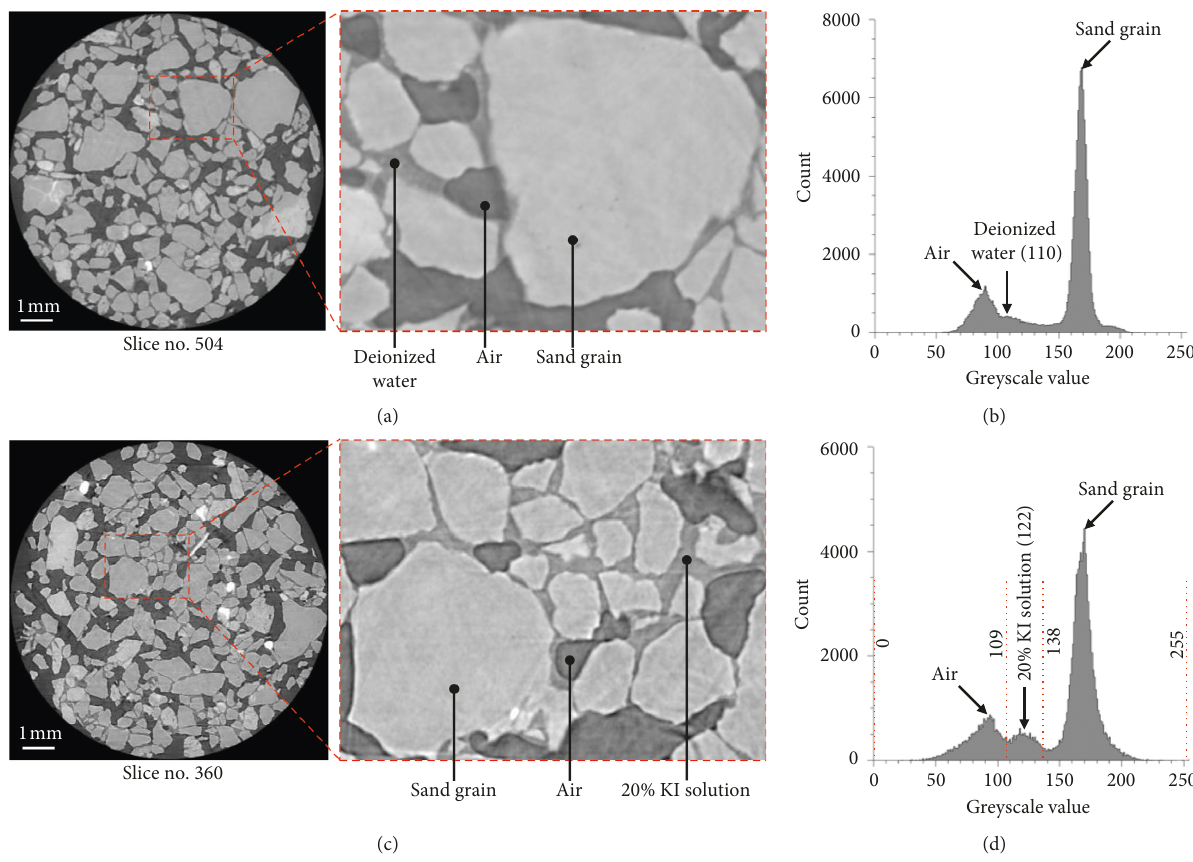
Figure 5: Slice image and greyscale histogram of the compacted Zhuhai sand. (a) Slice image and (b) histogram of the sand mixed with deionized water. (c) Slice image and (d) histogram of the sand mixed with 20% KI